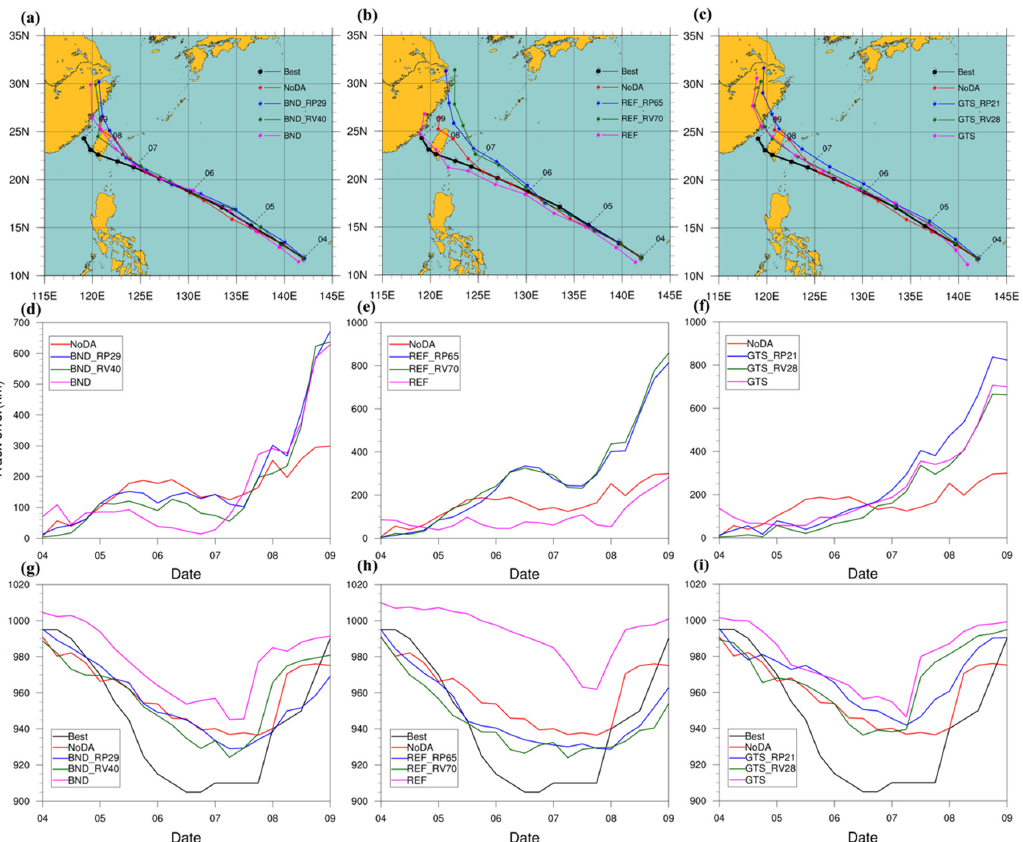
Figure 8. ( a ) The CWB best track (black line) and the forecasted tracks for BND (pink line), BND_RP (blue line), BND_RV (green line), and NoDA (red line) for Typhoon Nepartak. ( d ) as in ( a ) but for the track errors, and ( g ) as in ( a ) but for the central sea-level pressure error. ( b , e , h ) as in ( a , d , g ), respectively, but for REF. ( c , f , i ) as in ( b , e , h ), respectively, but for GTS. The numbers following the case names indicate the number of cycle runs.